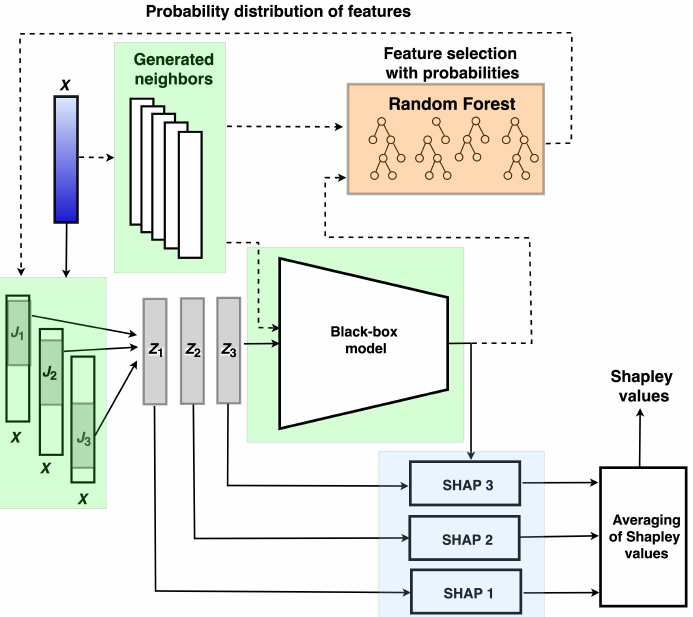
Figure 3. A scheme of the ER-SHAP-RF.